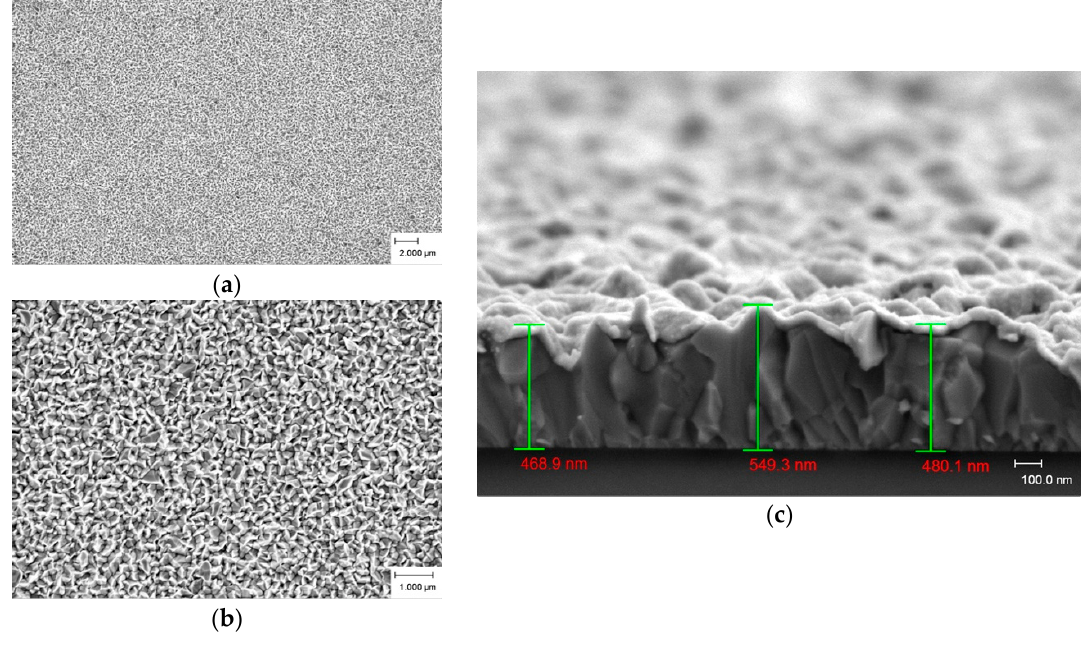
Figure 3. FESEM images of as-deposited ZnO products prepared at 500 C. ( a ) low magnification; ( b ) high magnification; and ( c ) cross section.